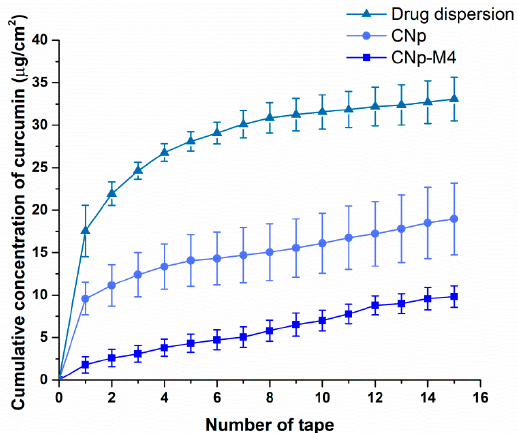
Figure 9. Cumulative concentration of curcumin quantified in the stratum corneum of healthy volunteers. Drug extraction from 15 adhesive tapes applied to the treatment site after placing a CNp-M4 membrane, CNp dispersion, or drug dispersion for 6 h (mean ± SE; n = 4).